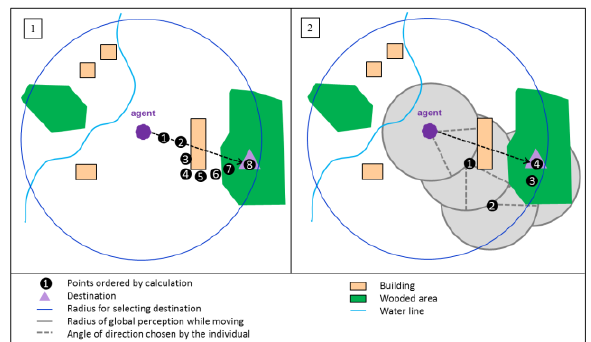
Figure 2. Overview of the principle of the two functions for an agent to build a trajectory between its actual location and the selected destination: 1) the first function takes into account the geometry of landscape features; 2) the second function calculates a cost value for movement.